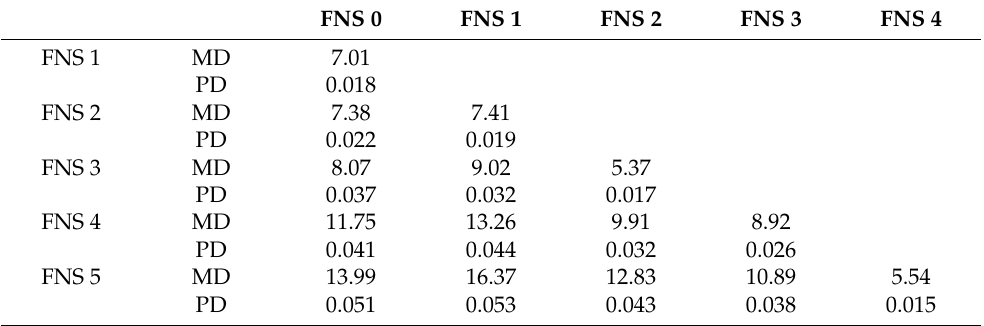
Table 3. Mahalanobis distances (MD) and Procrustes distances (PD) among the fatty neck score (FNS)